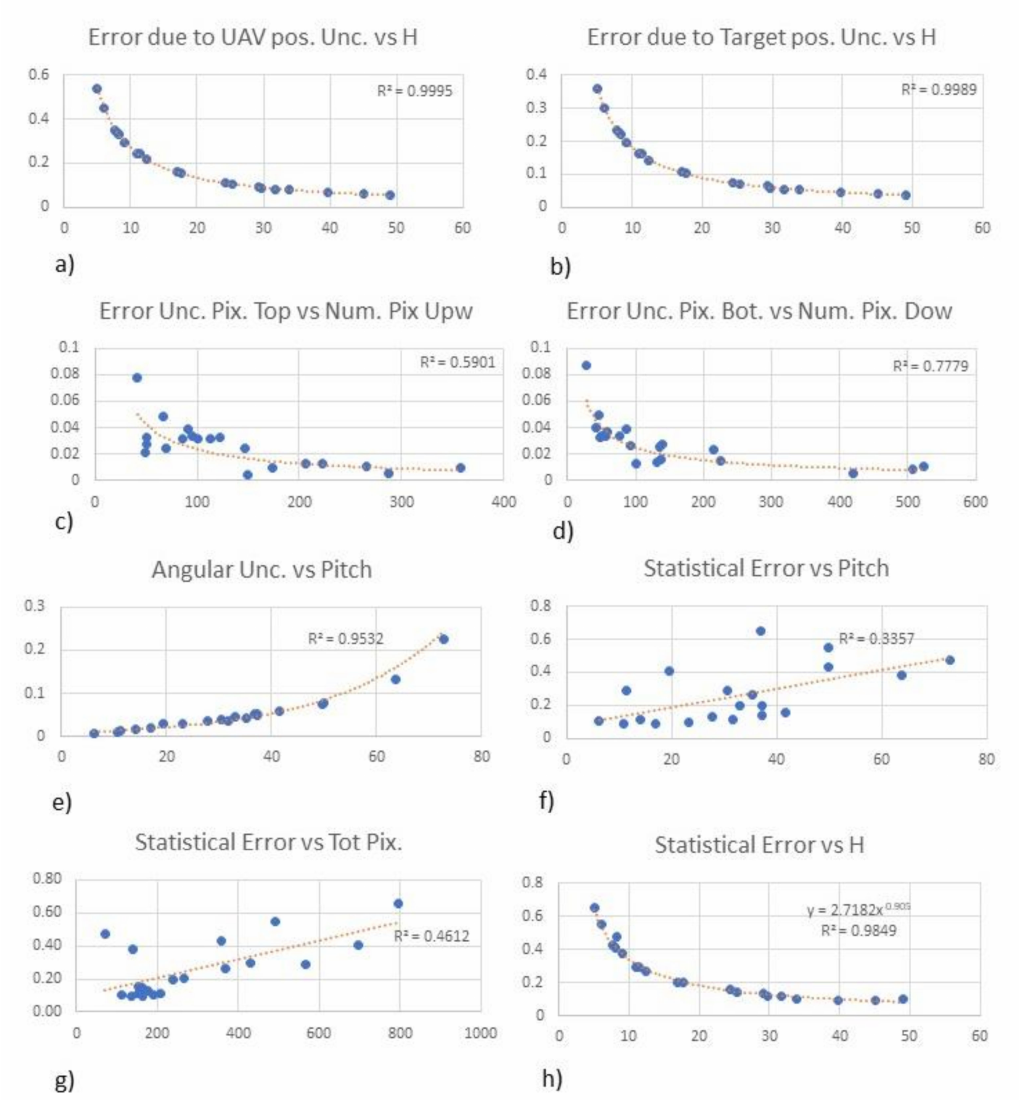
Figure 9. ( a ) Error in the estimation of height (obtained as: real target height—height estimation considering uav positional uncertainty) plotted against H (see Table 1). ( b ) Error in the estimation of height (obtained as: real target height—height estimation considering target positional uncertainty) plotted against H (see Table 1). ( c ) Error in the estimation of height (obtained as: real target height— height estimation considering uncertainty number of pixels toward top) plotted against pixels upwards (see Table 1). ( d ) Error in the estimation of height (obtained as: real target height—height estimation considering uncertainty number of pixels toward the bottom) plotted against Pixels downwards (see tabreftabref:remotesensing-938194-t001). ( e ) Angular uncertainty plotted against the pitch angle (see Table 1). ( f ) Combined statistical error plotted against pitch (see Table 1). ( g ) Combined statistical error plotted against the total pixels (pixels downwards + pixels upwards, see Table 1). ( h ) Combined statistical error plotted against H (see Table